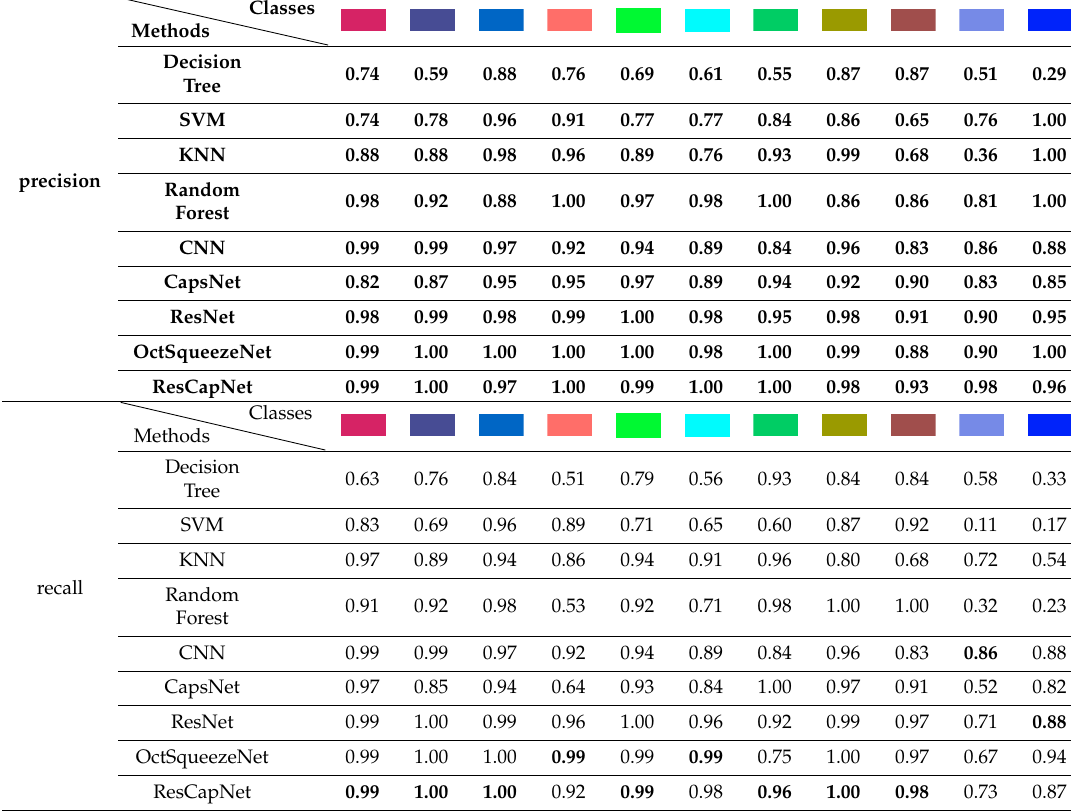
Table 5. Precision and recall of each class for 700 samples on Recology data set.